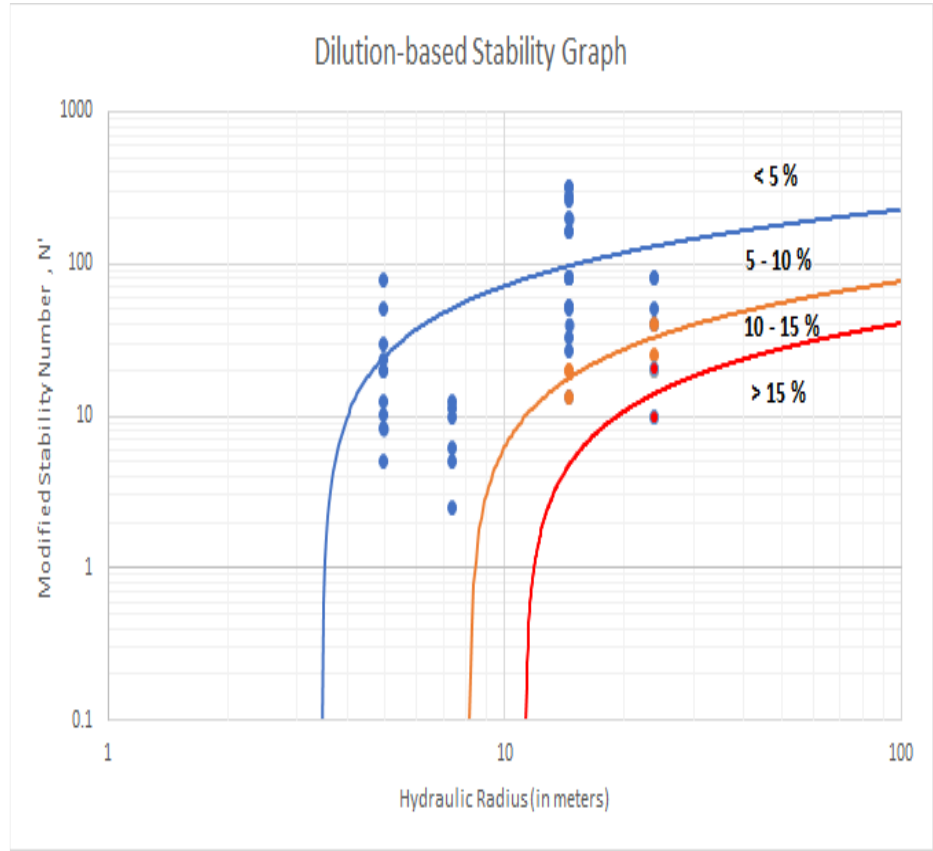
Figure 10. Proposed dilution-based stability graph approach .